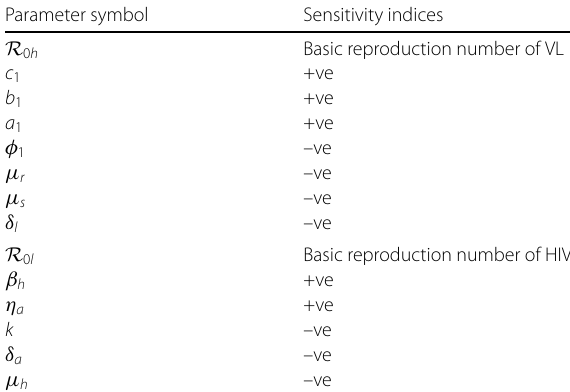
Table 2 Sensitivity indices